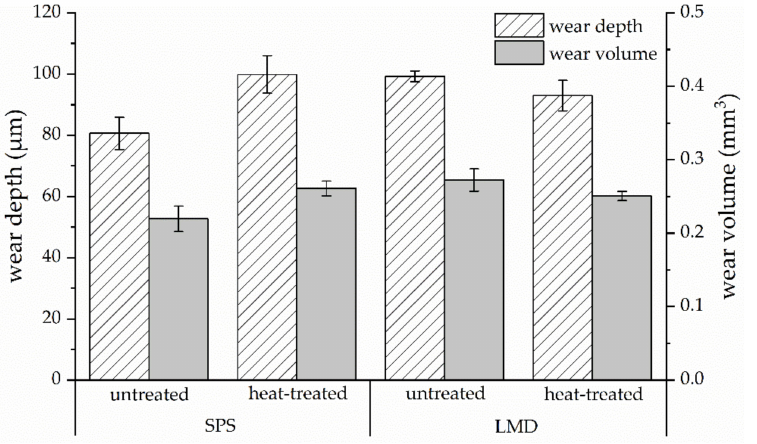
Figure 7. Reciprocating wear test of the untreated and heat-treated SPS bulk material and LMD coating of Al 0.3 CoCrFeNiNb 0.5 . The untreated SPS bulk material exhibited the highest wear resistance. By heat treatment, the wear resistance increased for the LMD coating and decreased for the SPS bulk